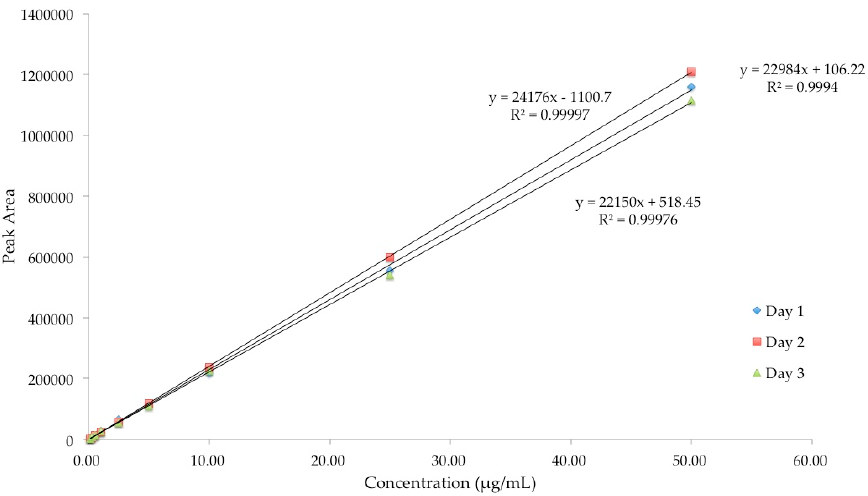
Figure 4. Linearity of HPLC method for analysis of buprenorphine.